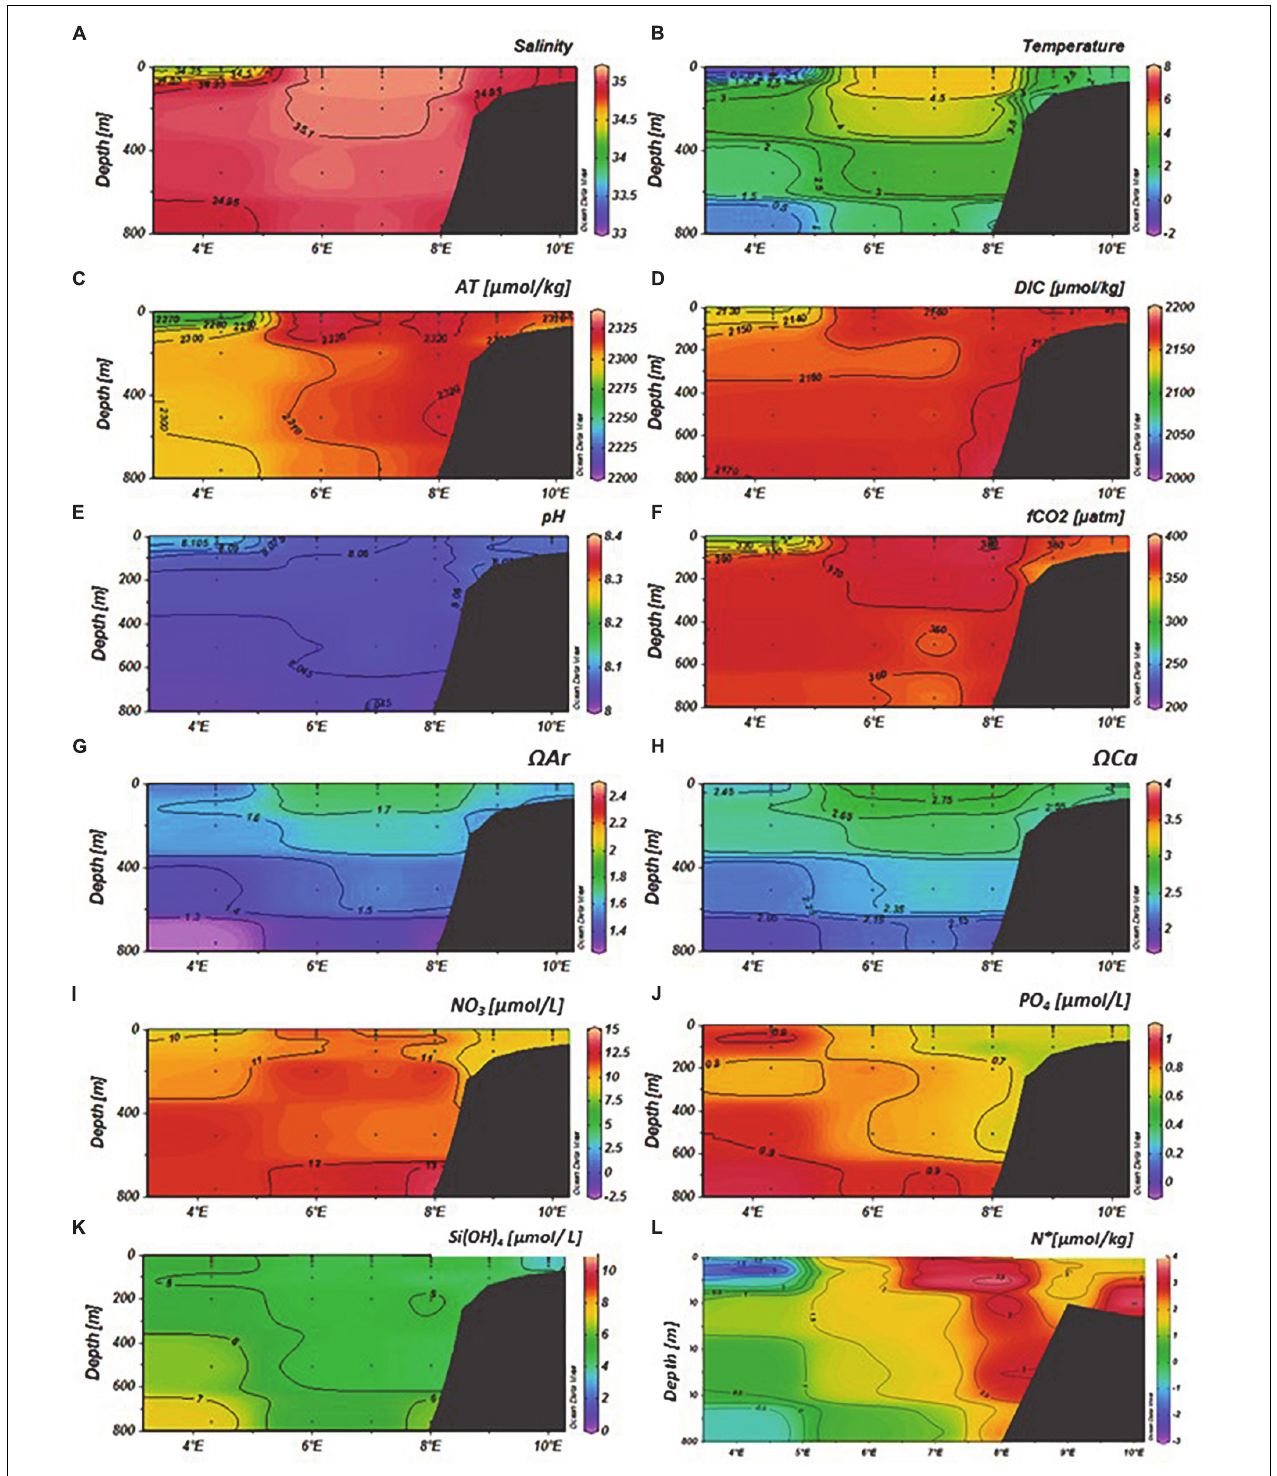
FIGURE 4 | Variability of physical and chemical parameters in the eastern Fram Strait (latitude: 79–79.5 ◦ N, longitude: 4–10 ◦ E) in January 2014 from top; (A) salinity, (B) temperature ( ◦ C), (C) total alkalinity (AT, µ mol kg − 1 ), (D) total dissolved inorganic carbon (DIC, µ mol kg − 1 ), (E) pH, (F) fugacity of carbon dioxide ( f CO 2 , µ atm), (G) aragonite saturation ( (cid:127) Ar), (H) calcite saturation ( (cid:127) Ca), (I) nitrate (NO 3 , µ mol L − 1 ), (J) phosphate (PO 4 , µ mol L − 1 ), (K) silicic acid (SiOH 4 , µ mol L − 1 ), and (L) N ∗ ( µ mol kg − 1 , negative values denote denitrification, and positive values show nitrification). The sampling locations and depths are denoted as black dots. The section plot and interpolation were performed by the Ocean Data View program (Schlitzer,